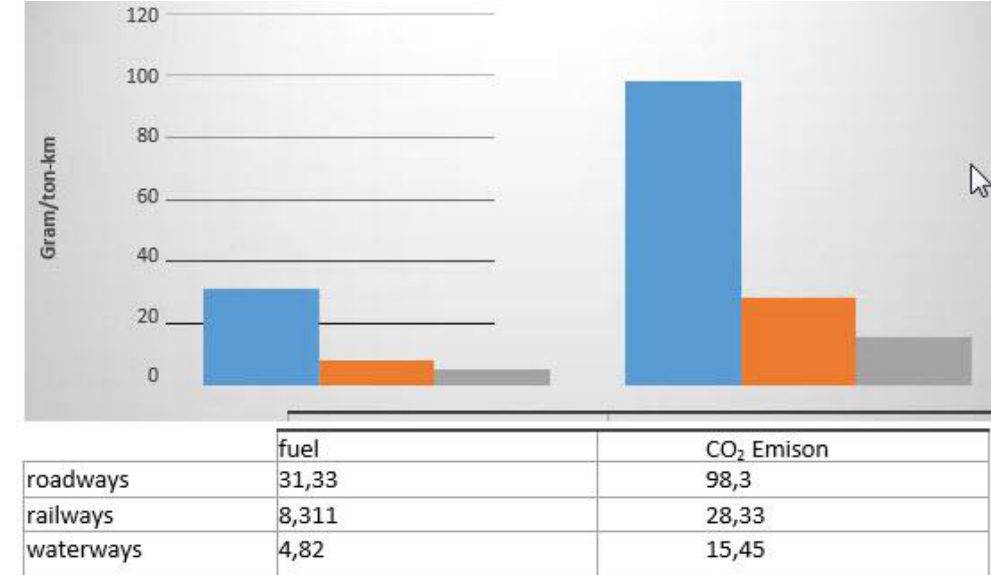
Fig 2. Average fuel consumption and CO2 emissions of transportation subsystems (Gram / ton-km). Source: International Energy Association. IEA and IPCC (2014) Summary for